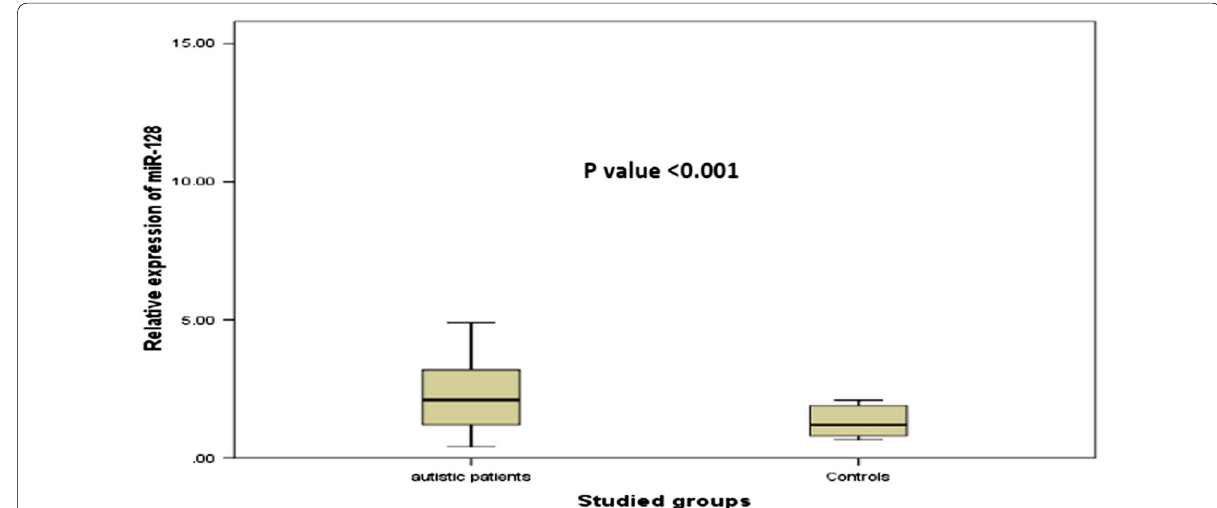
Fig. 2 MiRNA‑128 expression among the studied groups